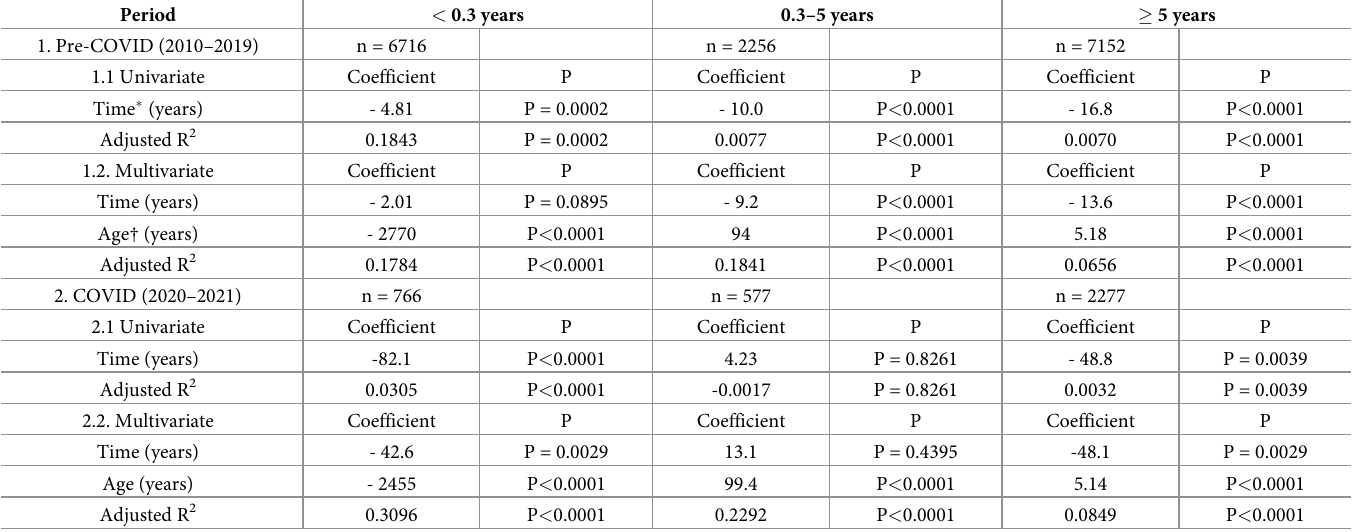
Table 2. Linear regression coefficients to explain IgG in different age